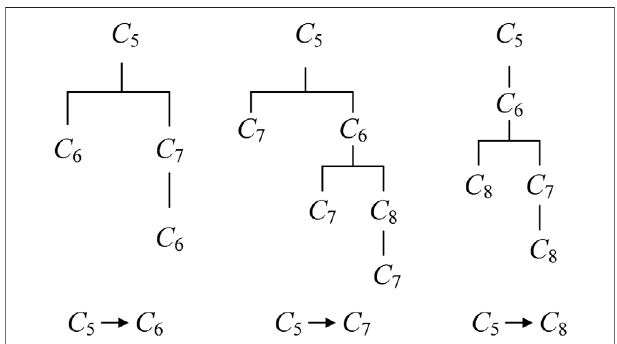
FIGURE 5 | Change propagation tree from C 5 to C 6 , C 7 and C 8